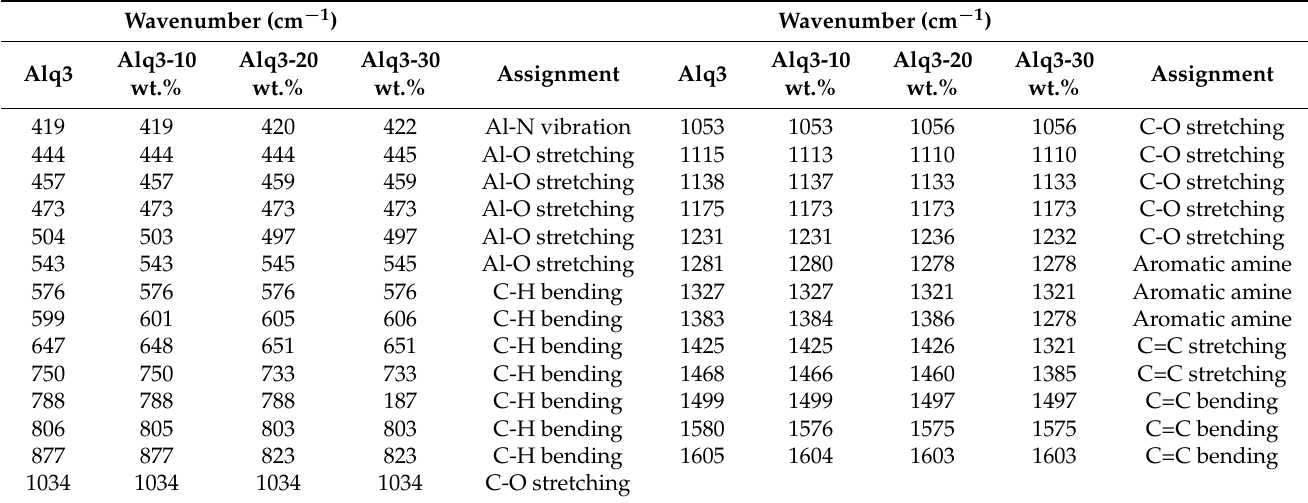
Table 1. IR Vibrational modes in FTIR spectra of pure Alq3 and Alq3-ZnO nanohybrids [3].